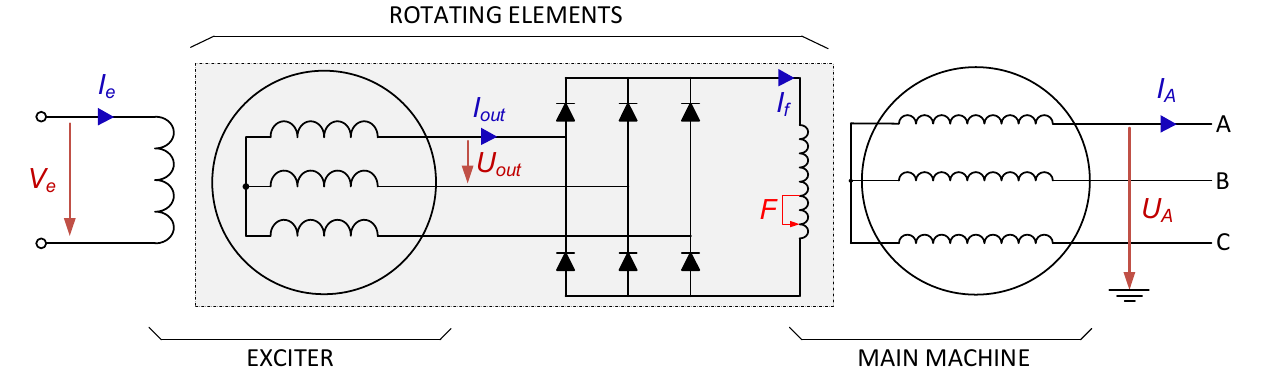
Figure 1. BSM simplified scheme (F: main machine field winding interturn fault).